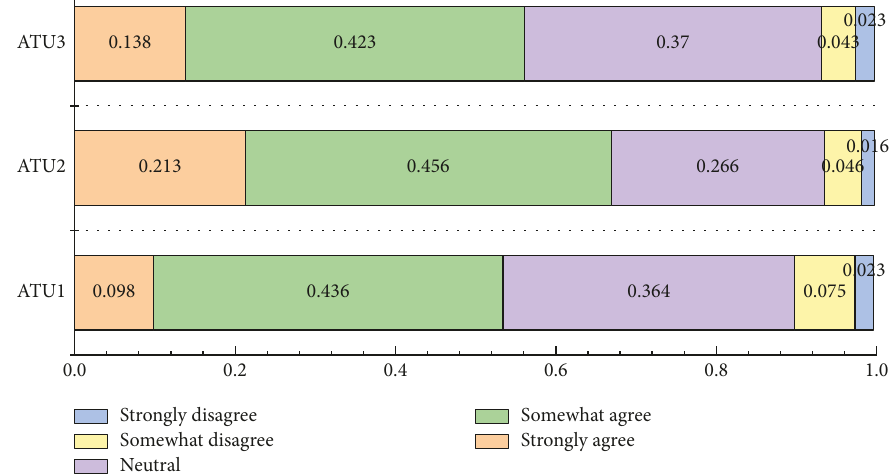
Figure 4: Attitude toward